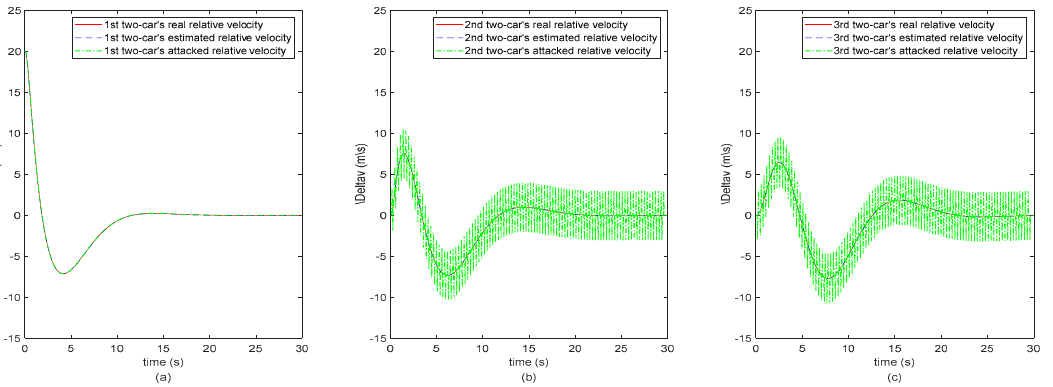
Figure 4. The three 2 ‐ cars’ relative velocity. ( a ) The 1st two ‐ car, ( b ) The 2nd two ‐ car, ( c ) The 3rd two ‐ car.